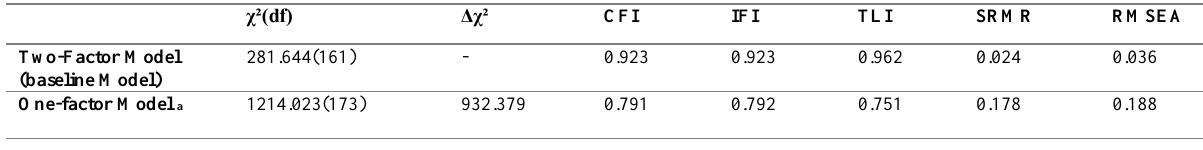
Table 1: Confirmatory factor analysis of task conflict and team